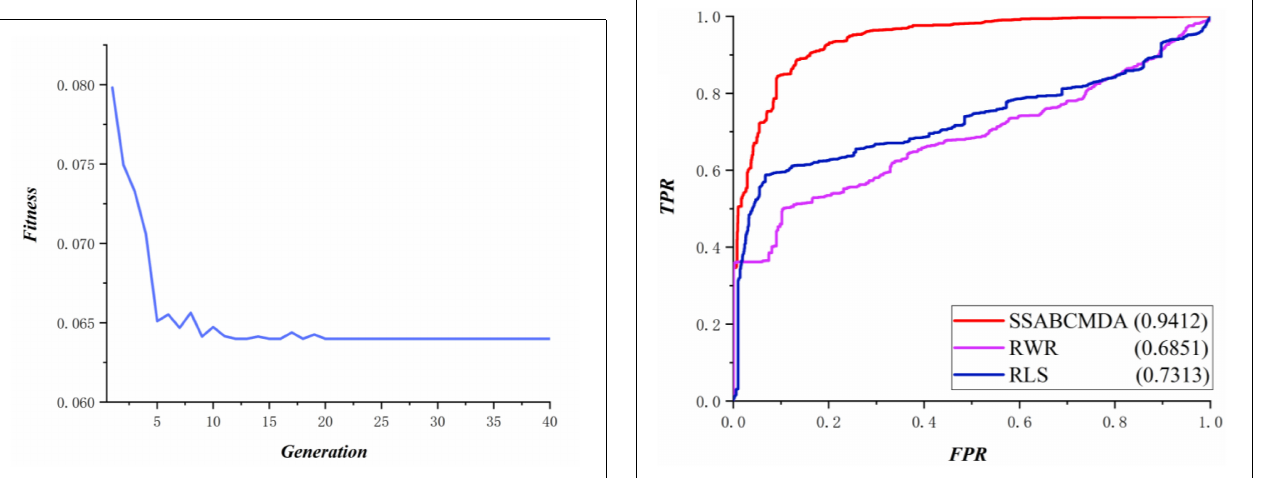
FIGURE 4 | The optimal fitness of each iteration. FIGURE 5 | Comparison results about